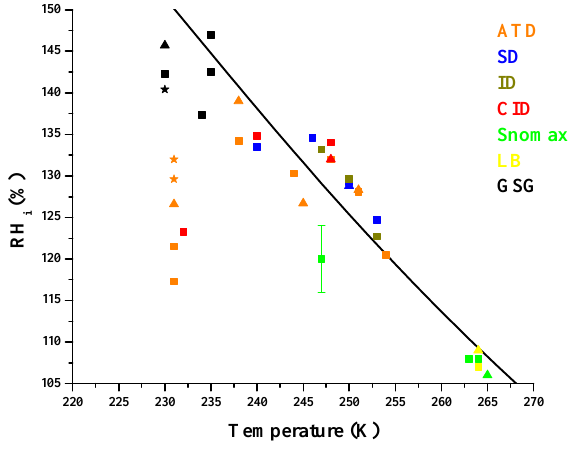
Fig. 2. Onset RH i for 0.1% activated ice fraction as a function of temperature for all aerosols sampled with the UT-CFDC. All data are based on the large particle channel ( > 5µm). UT-CFDC data at RH w > 100% and T > 250K could represent ice and/or water acti- vation. Triangles: aerosol sampled from AIDA chamber. Squares: aerosol sampled from APC chamber. Stars: aerosol sampled after a cloud expansion experiment in AIDA. Black line: Water satura- tion (Murphy and Koop, 2005). Uncertainty in all data points ±